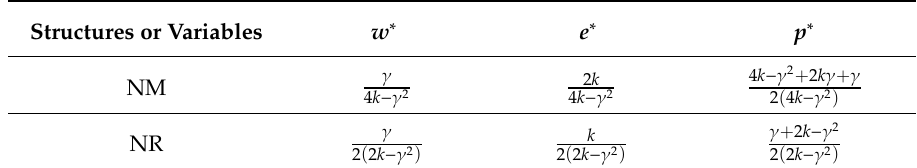
Table 1. The decisions of the supply chain under two di ff erent power structures with a wholesale price